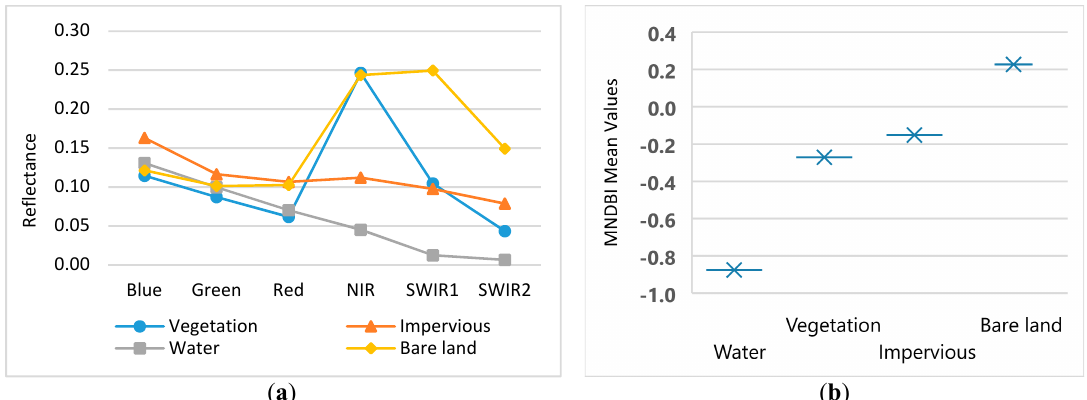
Figure 4. Reflectance of the typical land cover types in the Hong Kong study area: ( a ) band reflectance and ( b ) proposed modified normalized difference bare-land index (MNDBI).